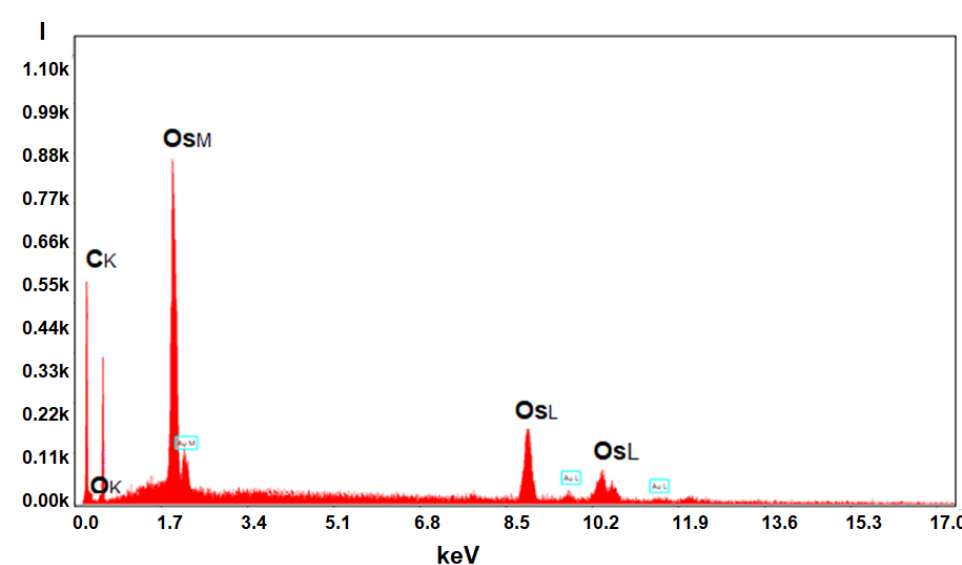
Figure 14. Formal energy-dispersive spectroscopy analysis (EDAX) for the osmium–polymer membranes.